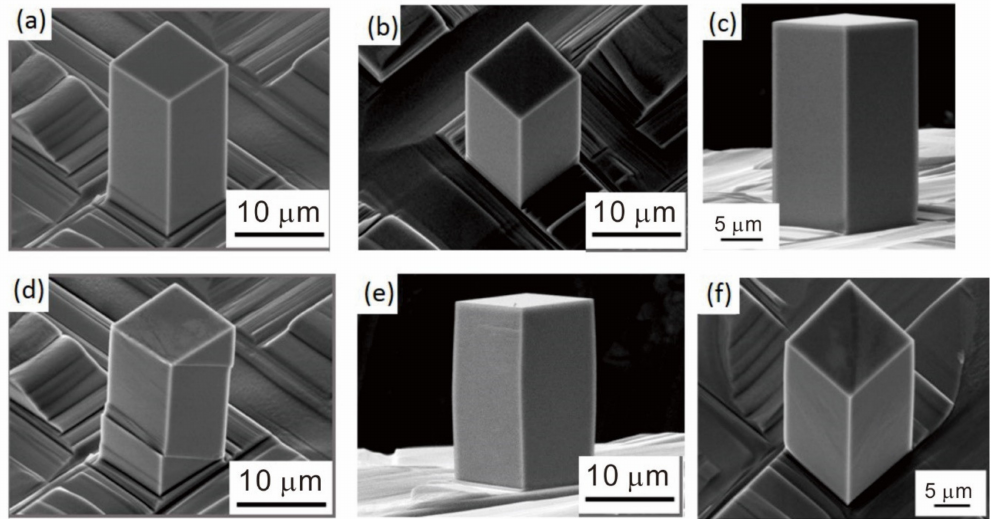
Figure 2. SEM images of the pillars before ( a – c ) and after ( d – f ) the micro-compression test. Orientations of the specimens: ( a , d ) [111]; ( b , e ) [011]; and ( c , f ) [001].